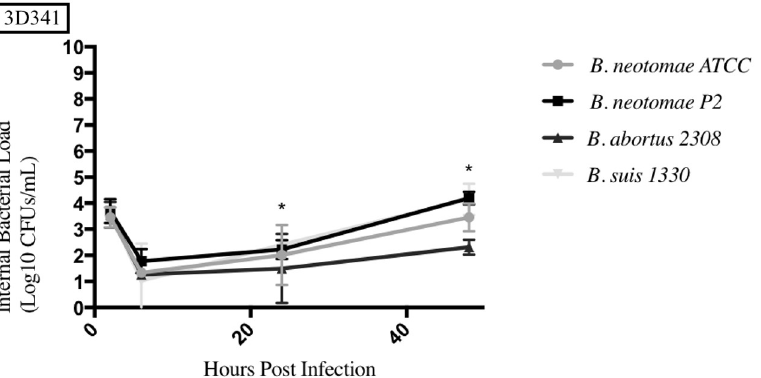
Fig 8. Intracellular survival of Brucella species in the swine monocyte cell line (3D4/31). Intracellular Brucella spp. CFUs were determined over 48hrs in 3D4/31 as described. Error bars represent the standard deviation of the triplicates from a single experiment. � represents when intracellular CFUs from more than one species tested statistically differs from BN with any p value lower than 0.05.